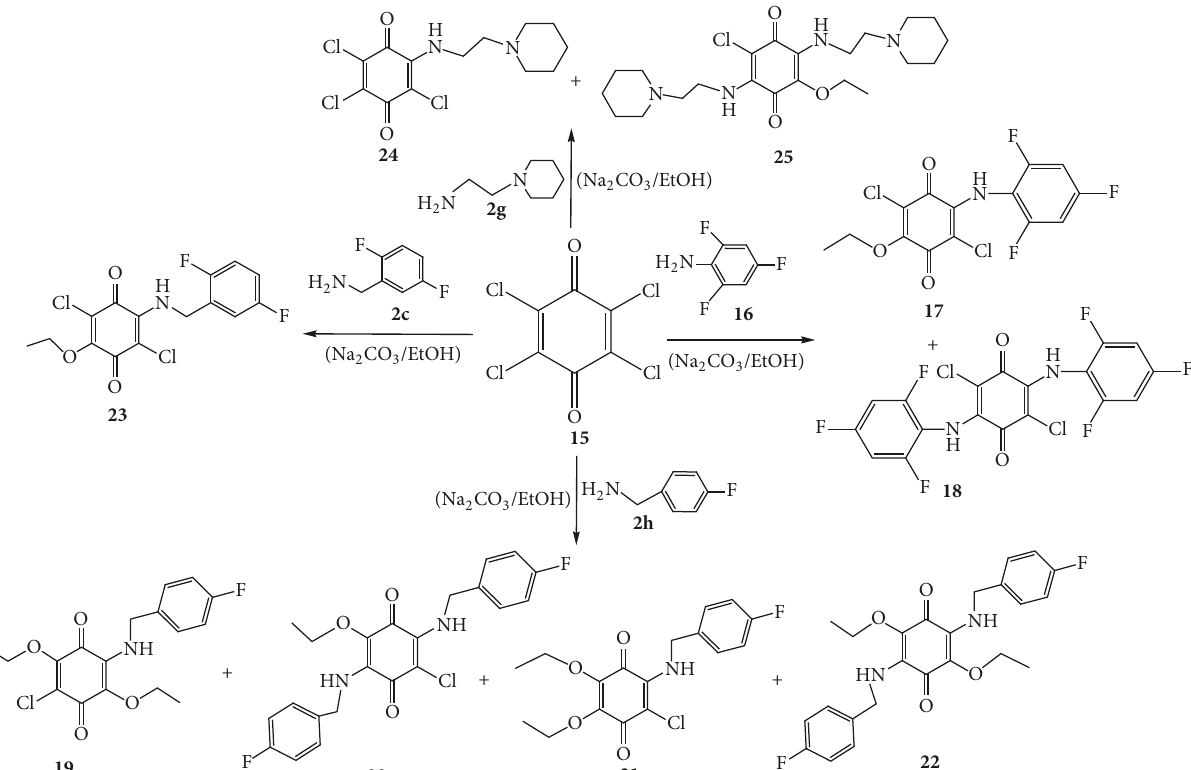
Scheme 3: The synthesis of N,O-substituted benzoquinone